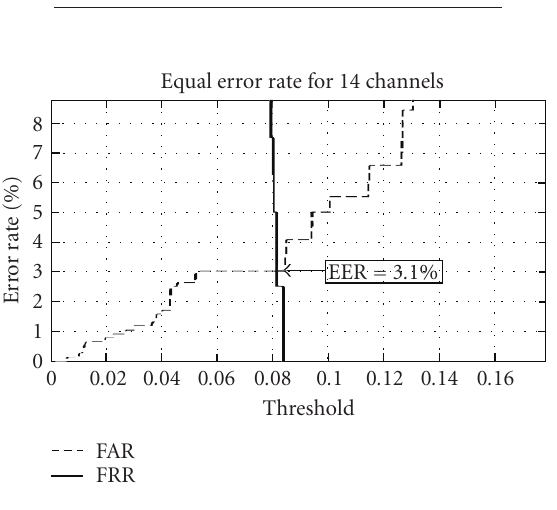
Figure 3.1 . EER for 14-channel